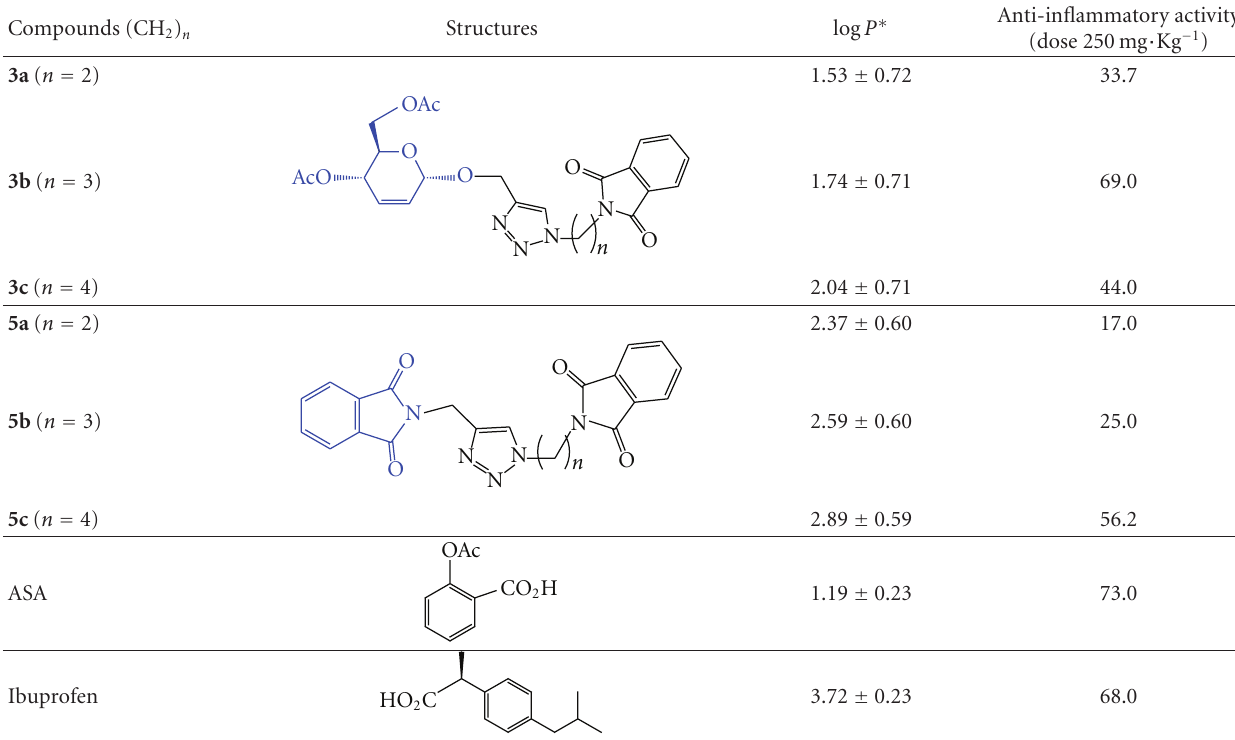
Table 2: Structure activity and log P values